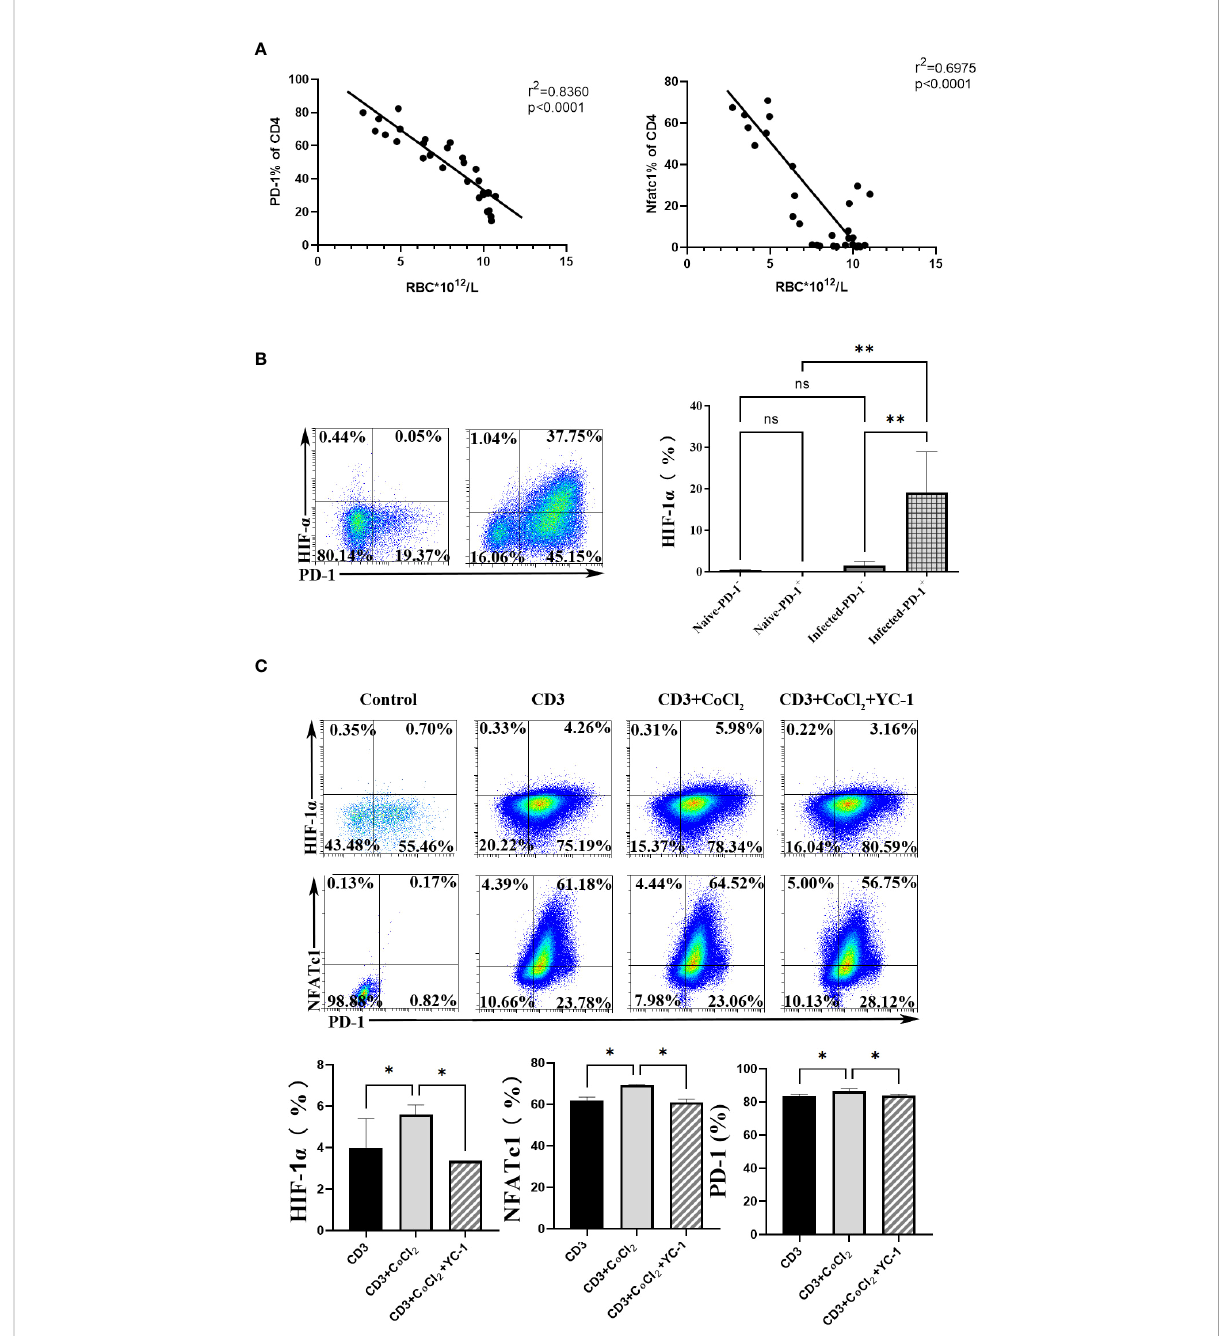
FIGURE 5 HIF-1 a was an important factor for NFATc1 expression after P. yoelii infection. (A) the correlation ship between the expression of PD-1 and NFATc1 and the erythrocyte density in P. yoelii infected mice. (B) the expression of HIF-1 a in PD-1 +/- CD4 T cells was veri fi ed by FCM. (C) 400 m M CoCl 2 was used to induce hypoxic conditions for CD4 T cells. And then the speci fi c inhibitor of HIF-1 a (YC-1) was used. The expression of HIF-1 a , NFATc1 and PD-1 was detected by qPCR. 3 – 7 samples were prepared for each group, and the experiments were repeated three times. The error bars represented number of mice. * p <0.05, ** p <0.01. ns, no statistical signi fi